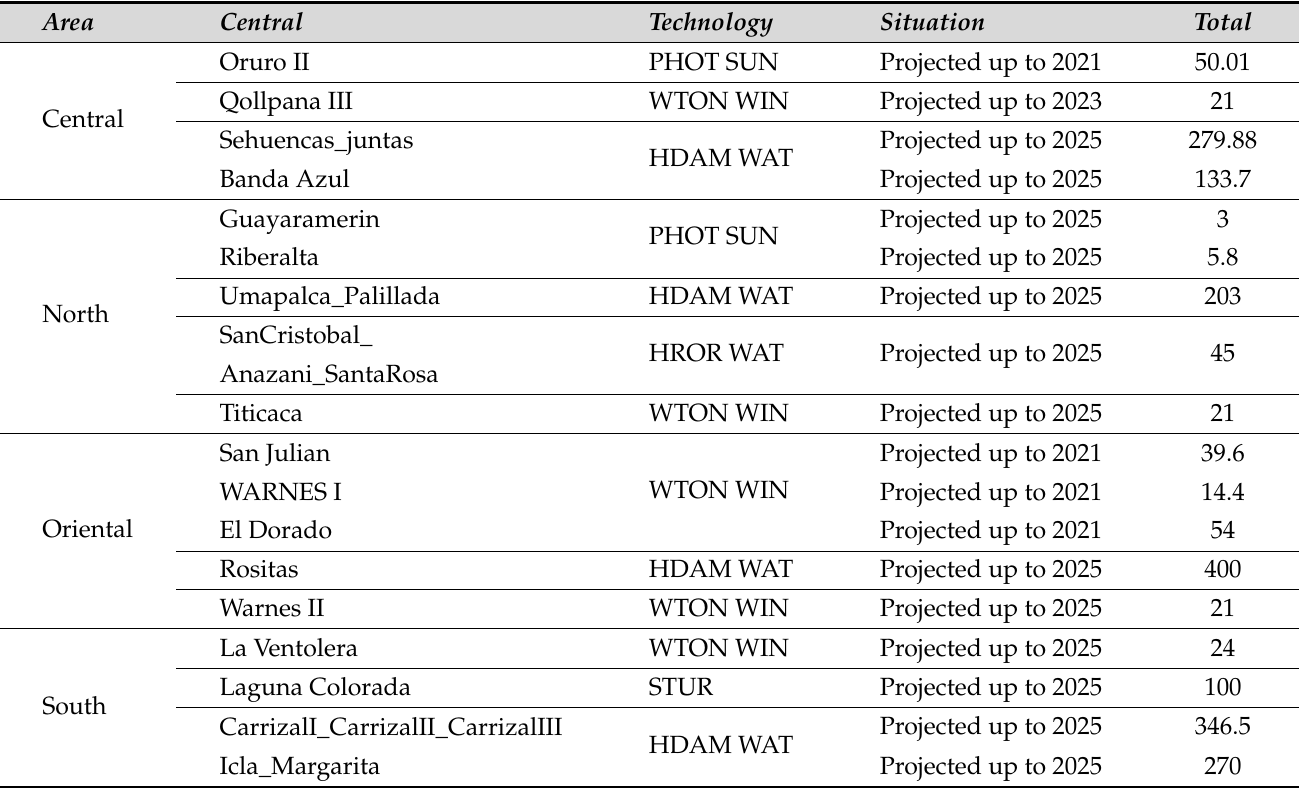
Table 3. Conventional and renewable generation projects planned for the period 2020–2025